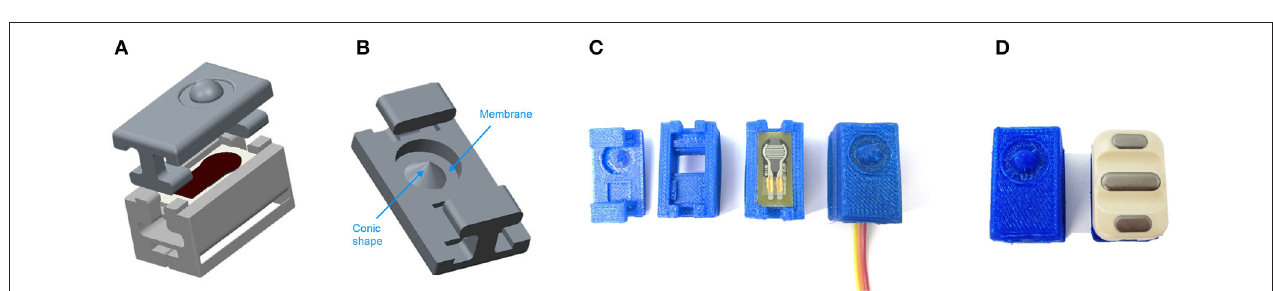
FIGURE 3 | (A) Exploded view of the 3D-model of the FSR housing. (B) 3D-model of the top part of the FSR housing, where the membrane and the conic shape are identified. (C) Assembly process of the housing and the FSR sensor. (D) Comparison between the final FSR sensor and the EMG sensor.